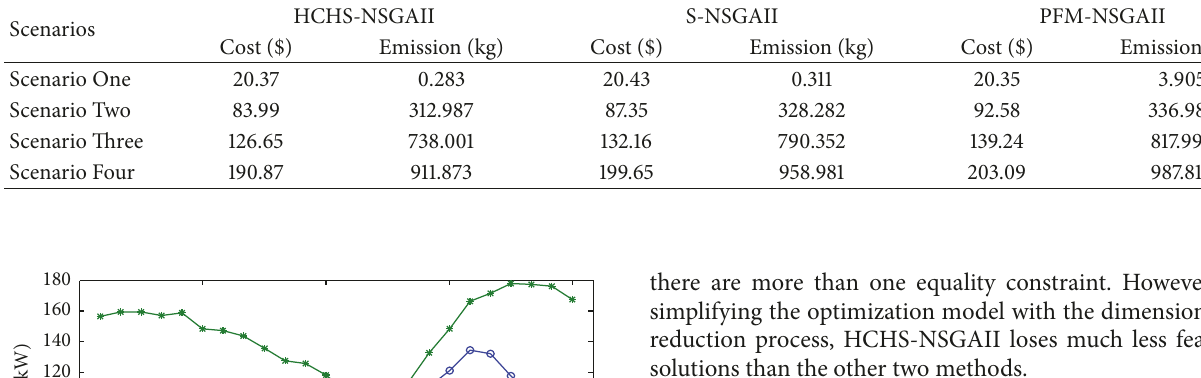
Table 3: The average feasible results of the total cost and emission obtained by the three methods.